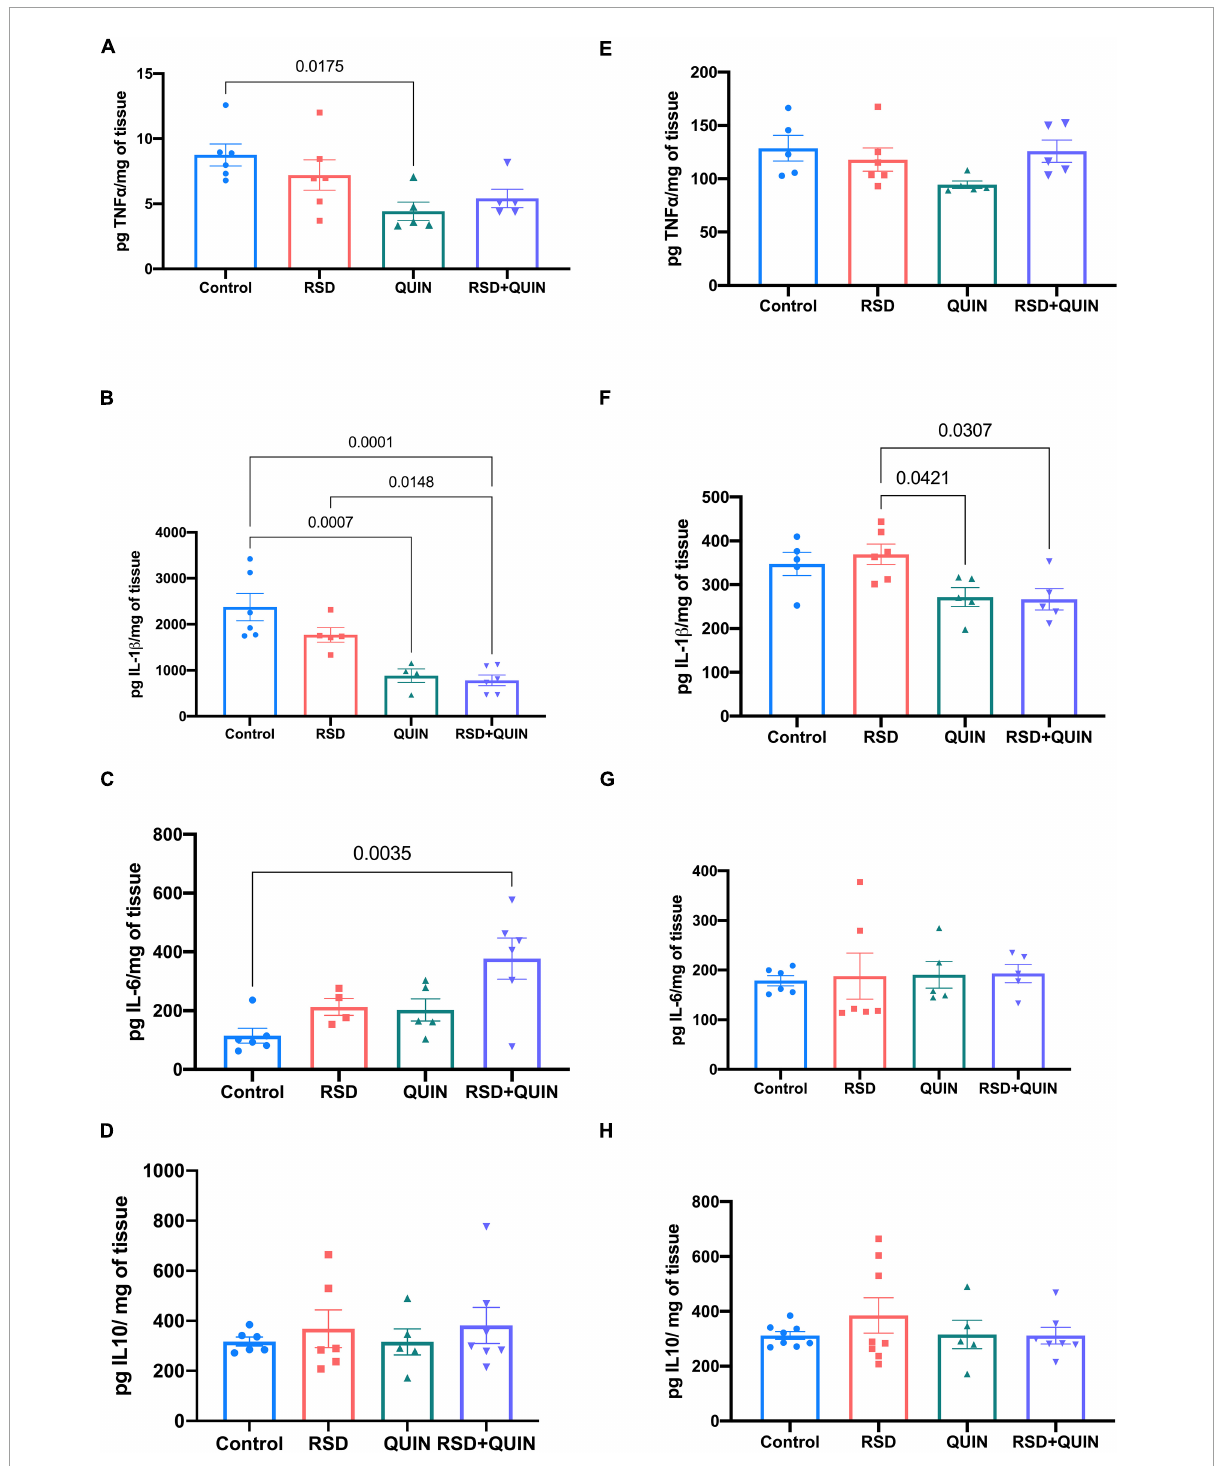
FIGURE2 Effect of Quinpirole (QUIN) administration on REM sleep deprivation (RSD) mice on cytokine levels in the cerebral cortex and striatum. Mice were administered with QUIN (2 mg/kg/day for 3 days) and subjected to RSD. The levels of cytokines were analyzed using ELISAs in the striatum (A–D) and the cerebral cortex (E–H) . Data are presented as the mean ± SEM and were analyzed using one-way ANOVA, followed by Tukey’s post-hoc test. For striatum TNF- α n = 5–6, IL-1 β n = 5–6, IL-6 n = 5–6, and IL-10 n = 5–7. For cerebral cortex TNF- α n = 5, IL-1 β n = 5, IL-6 n = 5–6, and IL-10 n = 5–8. Significant differences among the experimental groups are